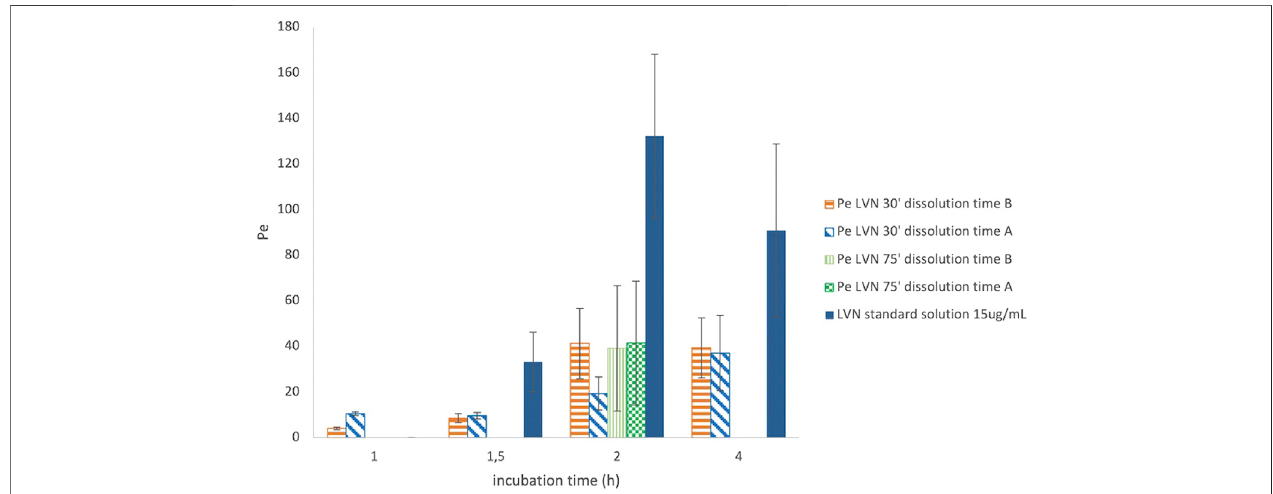
Frontiers in Chemistry |